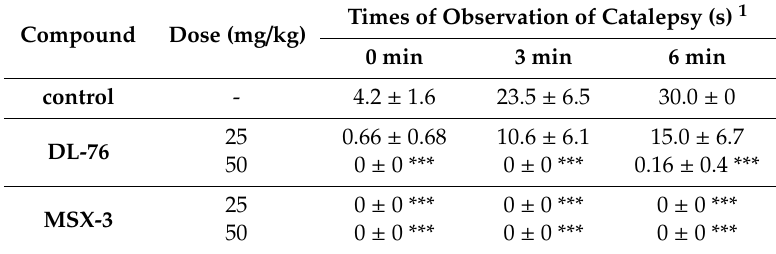
Table 4. Antiparkisonian activity of DL76 in the crossed-leg position